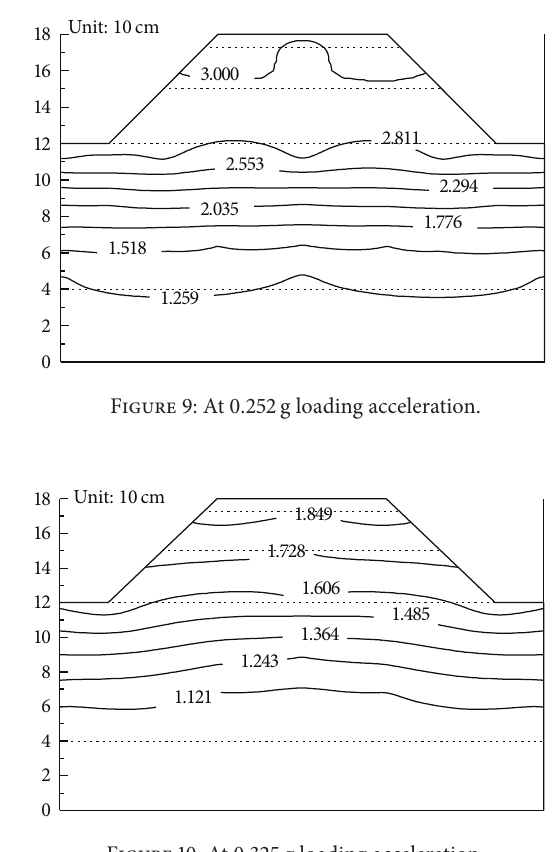
Figure 10: At 0.325 g loading acceleration.